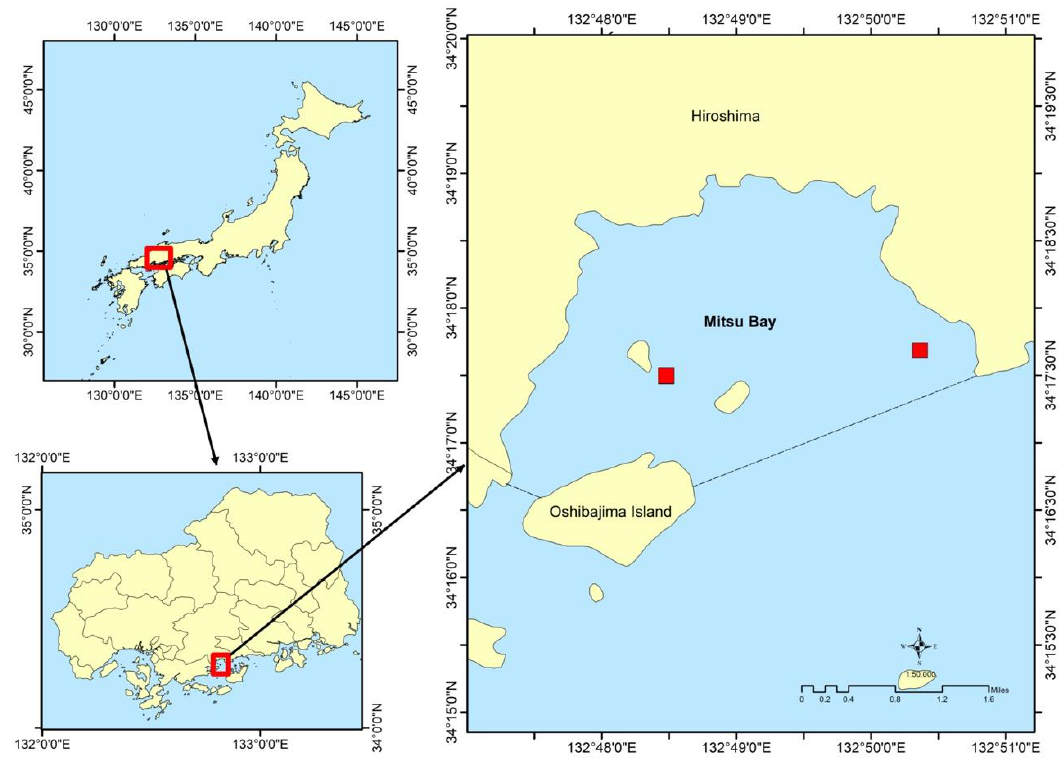
Figure 1. Locations of artificial timber reefs (ATRs) in Mitsu Bay, Higashi-Hiroshima, Japan. Red squares indicate the ATR areas and broken lines indicate the boundaries of the bay.